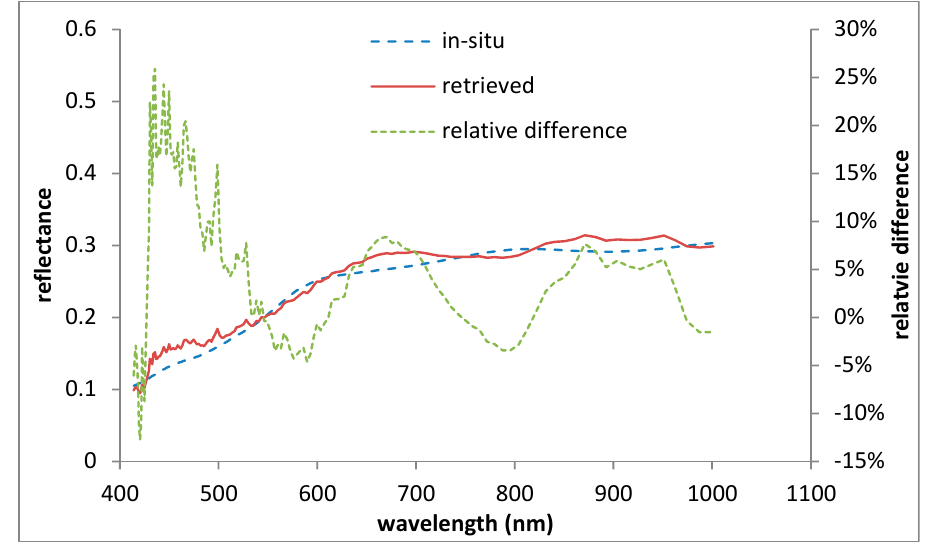
Figure 34. Comparison of in-situ desert reflectance measurements with retrieved reflectance from the SPARK-01 image acquired on 7 March 2017.